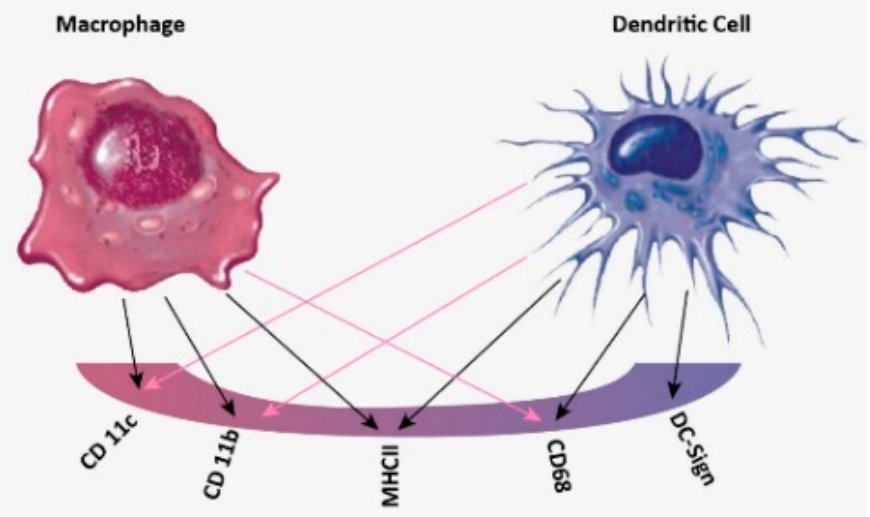
Figure 1. Overlapping of cell surface markers between MACs and DCs. DCs and MACs share the same surface markers CD11c, CD11b, MHCII, CD68.